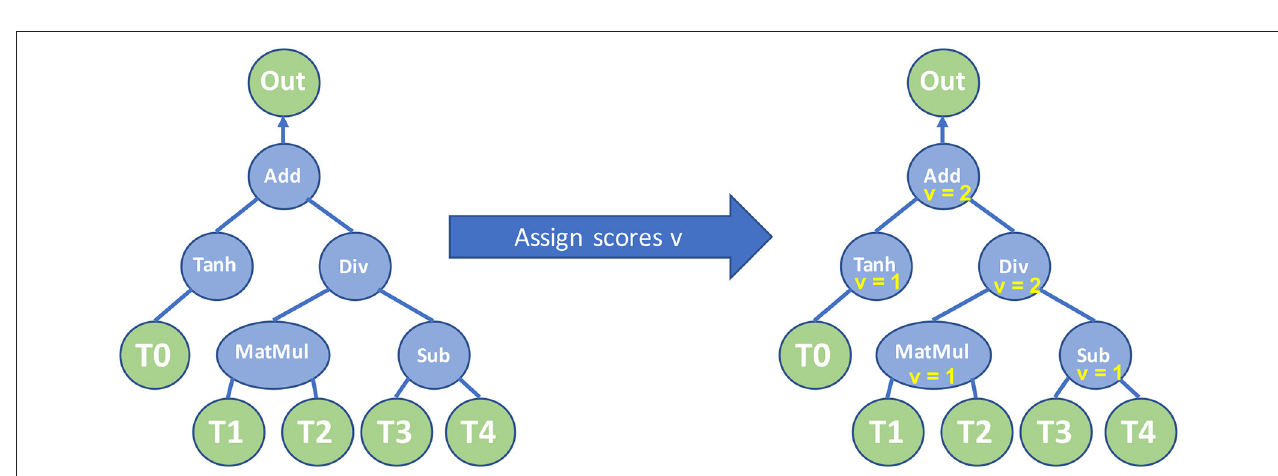
FIGURE 11 | Pseudocode for e x approximation with Taylor series on AVX512 x86 and ARM.